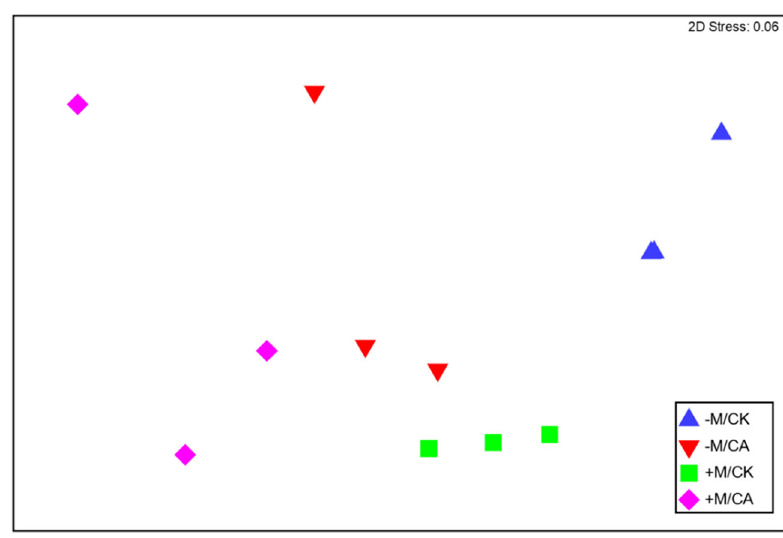
Fig. 3 The non-metric multi-dimensional scaling (NMDS) for soil parameters among treatments